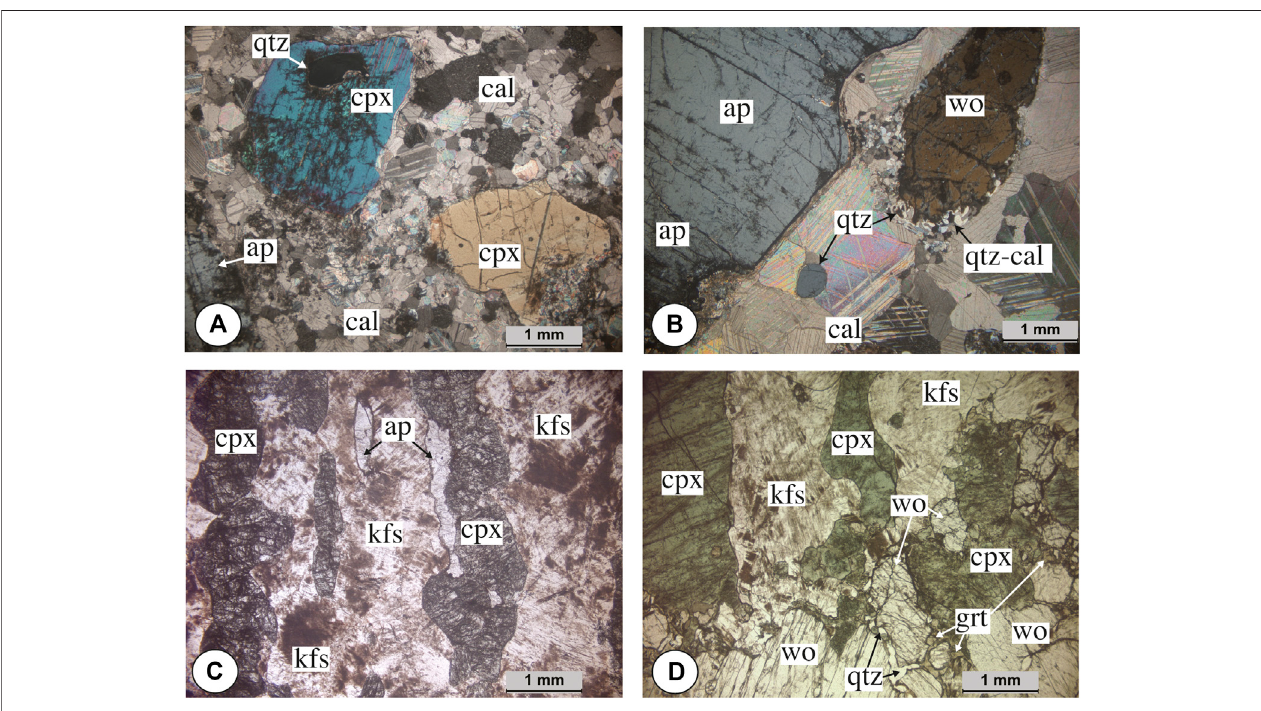
FIGURE3| Microphotographs of (A – B) carbonatitesand (C – D) syenites. (A) Si-poorbrecciatedcarbonatite withcalcite(cal), apatite (ap),and clinopyroxene(cpx) with quartz (qtz) inclusion. (B) Pegmatitic Si-rich carbonatite with apatite and wollastonite (wo) surrounded by quartz (qtz) and calcite. (C) Red syenite with altered K-feldspar (kfs) with apatite and clinopyroxene. (D) White syenite with K-feldspar, clinopyroxene, and wollastonite surrounded by garnet (grt) and